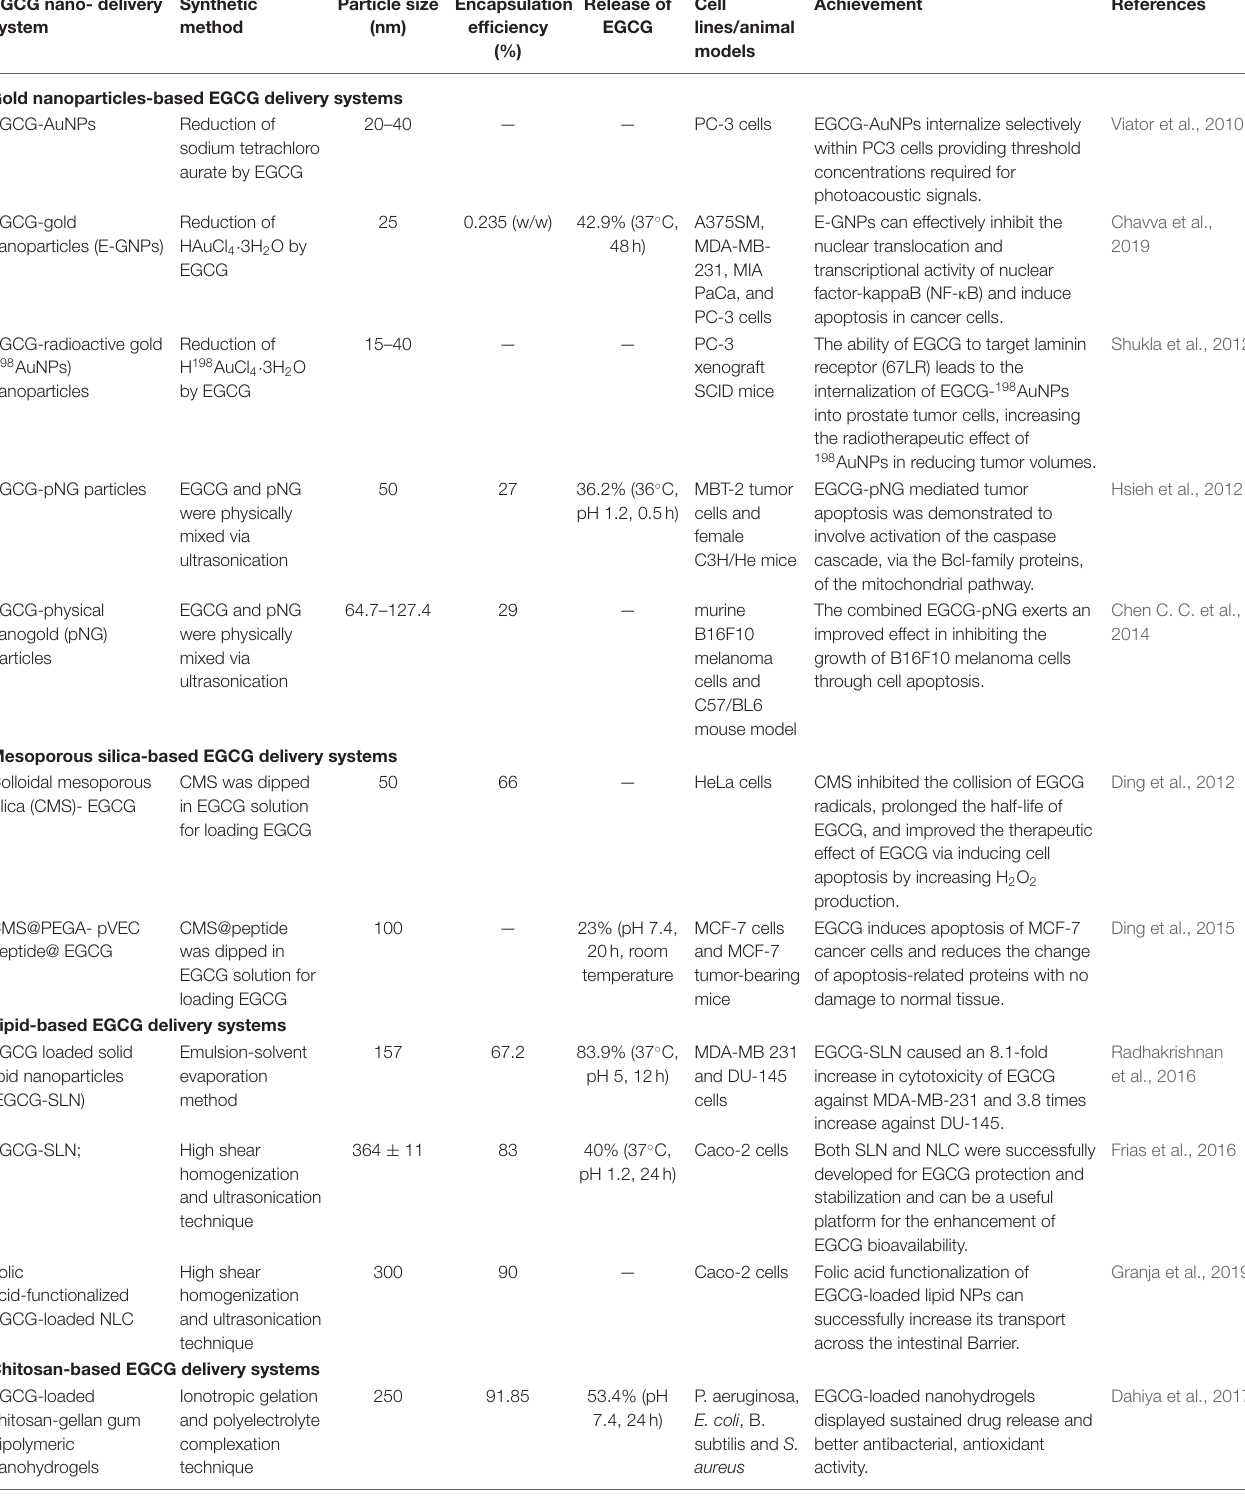
TABLE 1 | Summary of gold-, mesoporous silica-, lipid-, chitosan-, and protein-based EGCG delivery